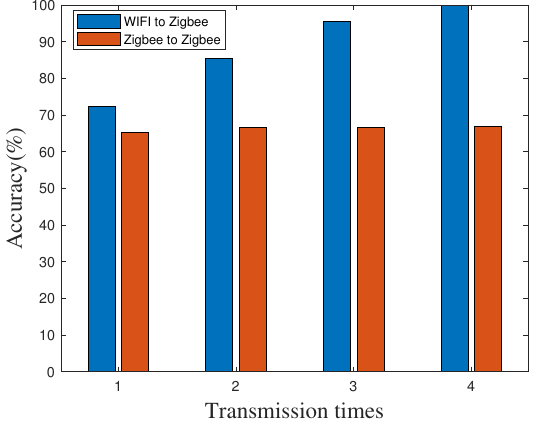
Figure 6. Time synchronization accuracy in different transmission times on the highway.